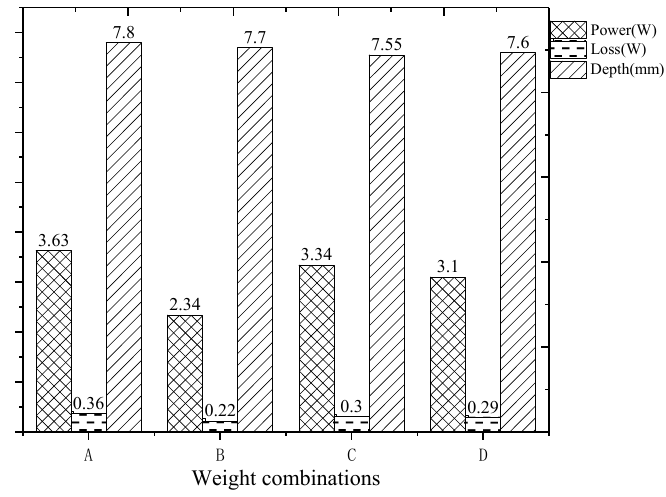
Figure 10. The result of comprehensive optimization.